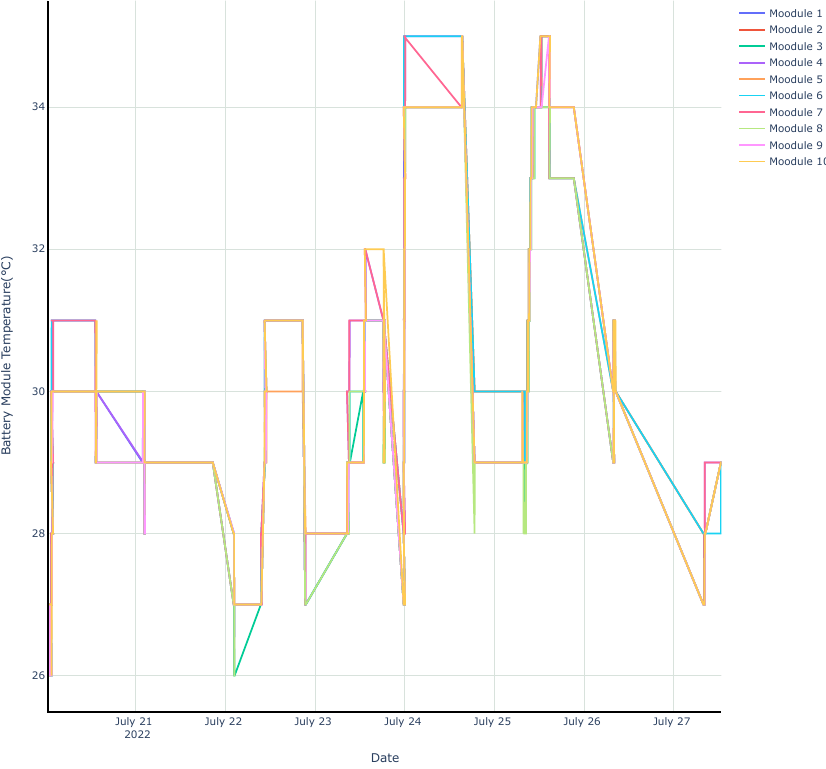
Figure 12. Comparison of maximum battery temperatures for battery pack modules in the Hyundai Ioniq Battery Electric, over a data collection period.